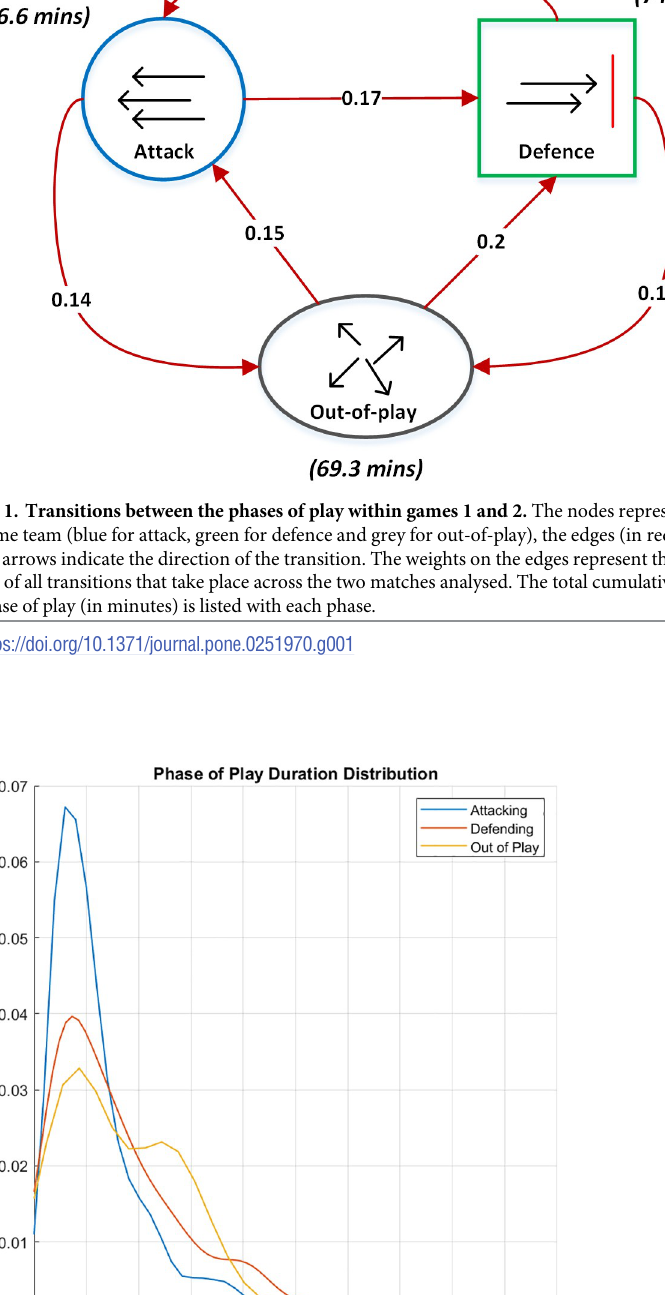
PLOS ONE | https://doi.org/10.1371/journal.pone.0251970 May 24,